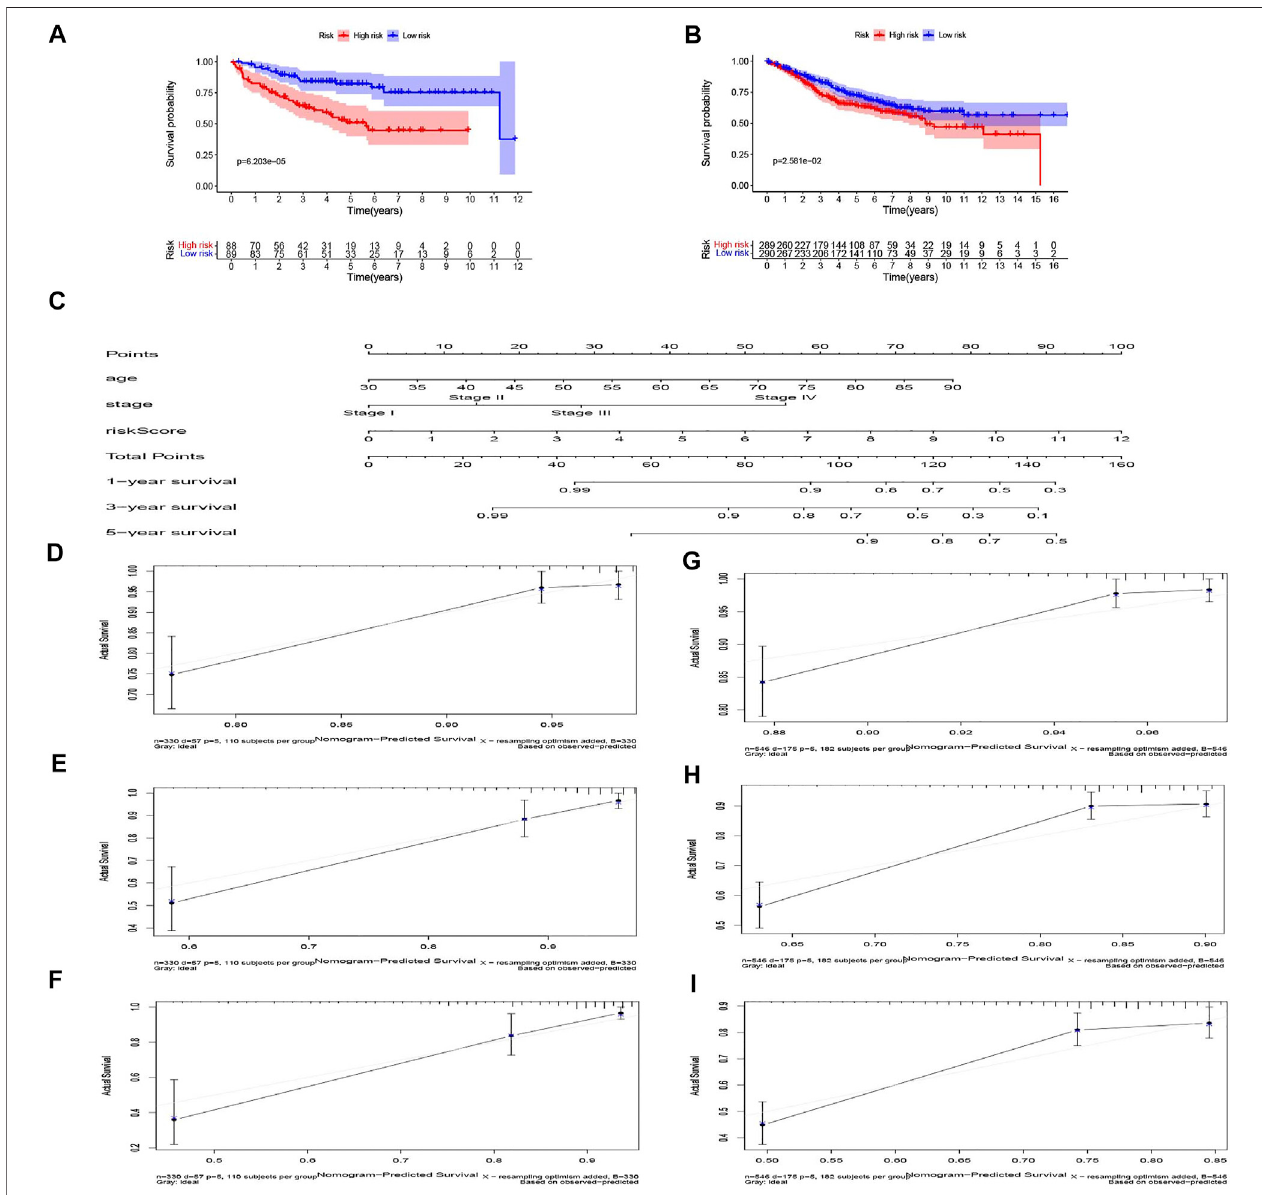
FIGURE5| ValidationoftheriskmodelintheGEOdatasetandnomogramforpredictingsurvivalrateinCOADpatients. (A) GSE17536and (B) GSE39582dataset. (C) Thenomogramforpredictingthe1,3,and5-yearsurvivalratebyage,stage,riskScore. (D – F) The1,3,and5-yearcalibrationcurvesofTCGAdataset. (G – I) The1,3, and 5-year calibration curves of Gene Expression Omnibus (GEO)